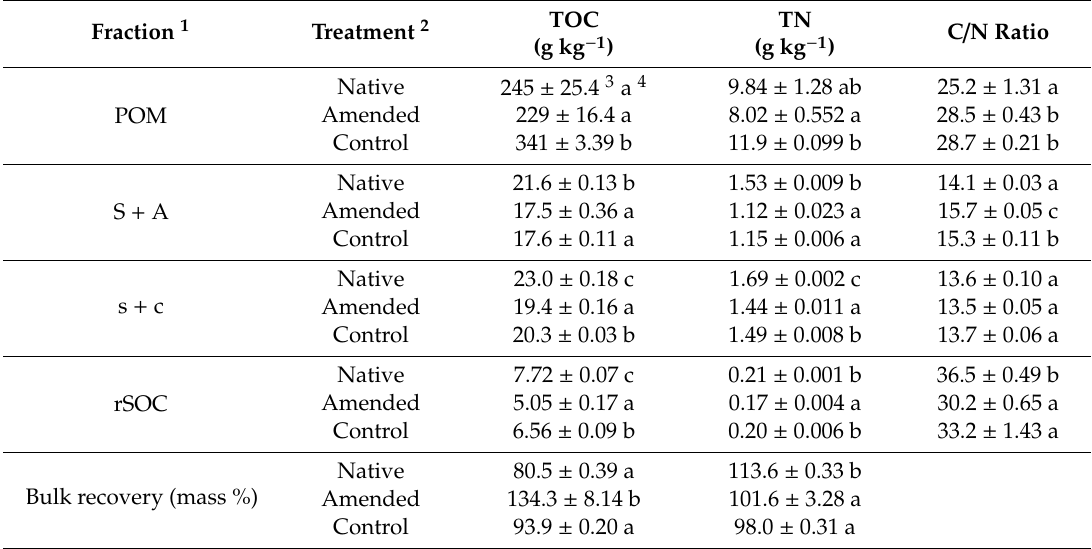
Table 1. Total C and N content and C / N ratio of the di ff erent soil fractions in the Luvisol